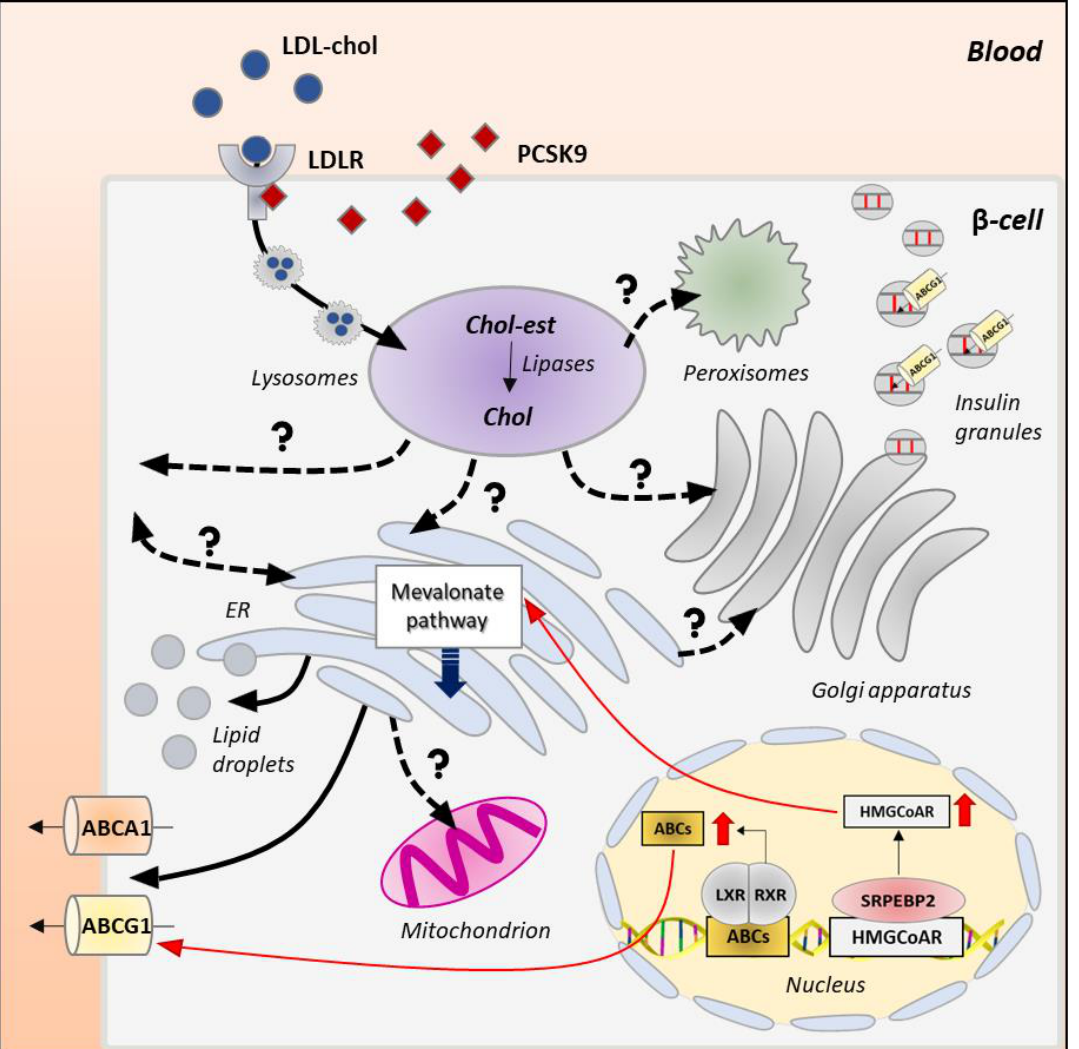
Figure 3. Intracellular itinerary of cholesterol in β -cells. Cholesterol is synthesized in the endoplasmic reticulum (ER) through the mevalonate pathway, which is controlled by the SREBP2-HMGCoAR axis (red arrow). Once synthesized, free cholesterol can be transported to the mitochondria, the Golgi apparatus and the plasma membrane; the mechanisms underlying cholesterol delivery to these organelles are completely unknown in pancreatic β -cells (dotted lines and question marks). Circulating LDL-cholesterol (LDL-Chol) is internalized in pancreatic β -cells by LDLR-me- diated endocytosis and delivered to the lysosomes via clathrin-coated vesicles. A key regulator of this process is the proprotein convertase subtilisin/kexin type 9 (PCSK9), which routes LDLRs to the somes, LDL-cholesterol (Chol-est) is metabolized by acid lipases to yield free cholesterol (Chol) that is transported to downstream organelles (plasma membrane, Golgi apparatus, peroxisomes and ER) through yet unknown mechanisms (dotted lines and question marks). Cholesterol accumulates also in insulin granules through ABCG1-mediated transport. Excessive free cholesterol is stored in lipid droplets or removed by ABCA1 and ABCG1 transporters, whose expression is controlled by LXR- RXR transcription factors (red arrow).